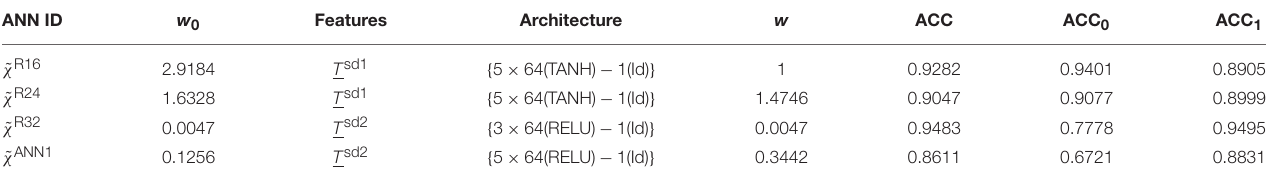
TABLE 4 | ANNs for error classification for ¯ σ R16 / 24 / 32 and ¯ σ ANN1 of previous section with tolerances τ a = 2MPa and τ r =